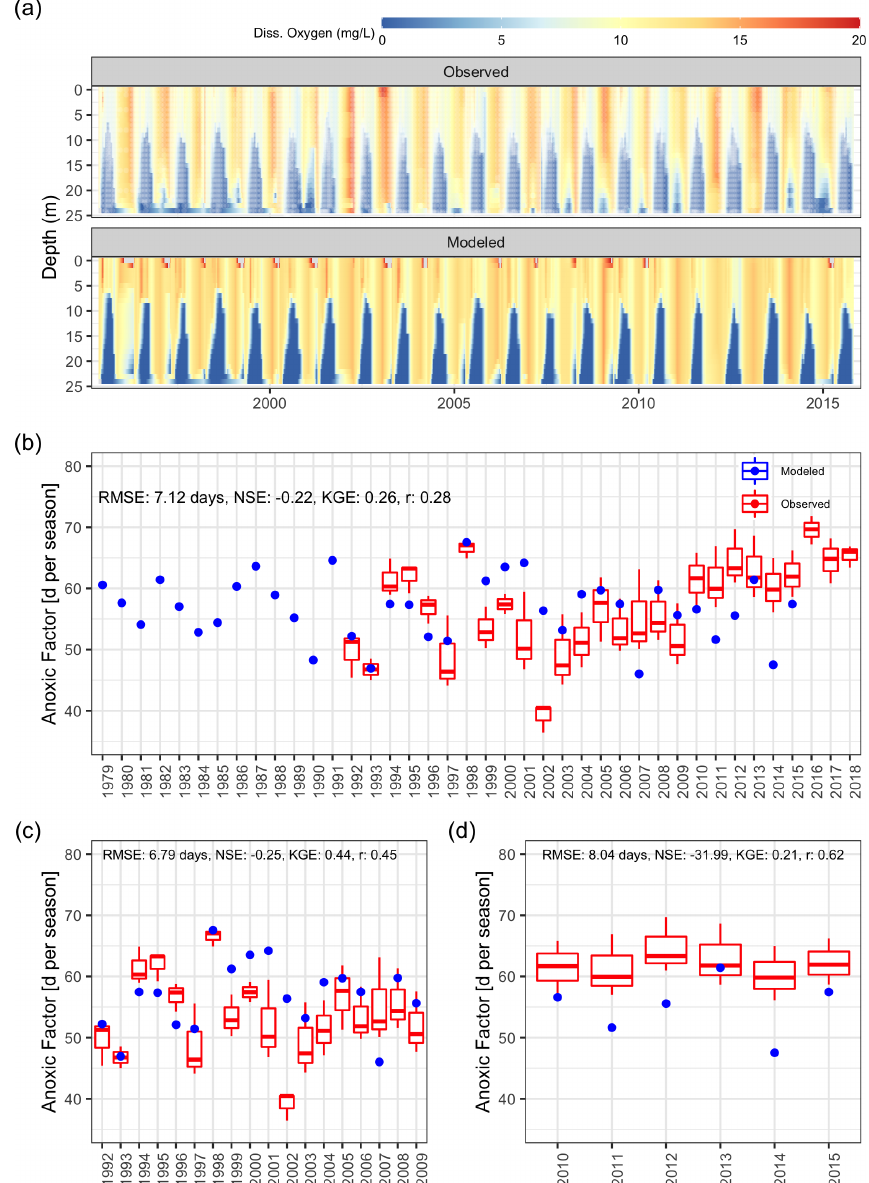
Figure 10. Comparison of observations to GLM-AED modeled dissolved oxygen concentrations and ecosystem response. (a) Contour plot of observed (upper figure, white dots mark sample events) and simulated dissolved oxygen concentrations. (b) Comparison of simulated anoxic factor (blue dots) against interpolated range of anoxic factor derived from observed data (box–whisker plots) over the period 1979 to 2018. (c) Comparison of simulated anoxic factor (red dots) against interpolated range of anoxic factor derived from observed data (box–whisker plots) over the period 1992 to 2009. (d) Comparison of simulated anoxic factor (red dots) against interpolated range of anoxic factor derived from observed data (box–whisker plots) over the period 2010 to